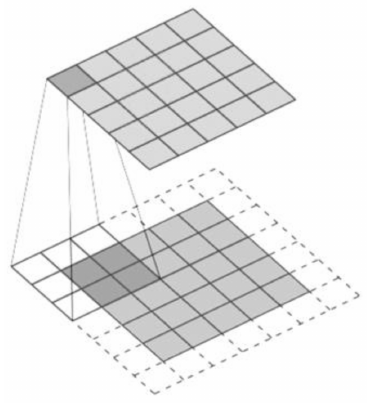
Figure 4. Convolution